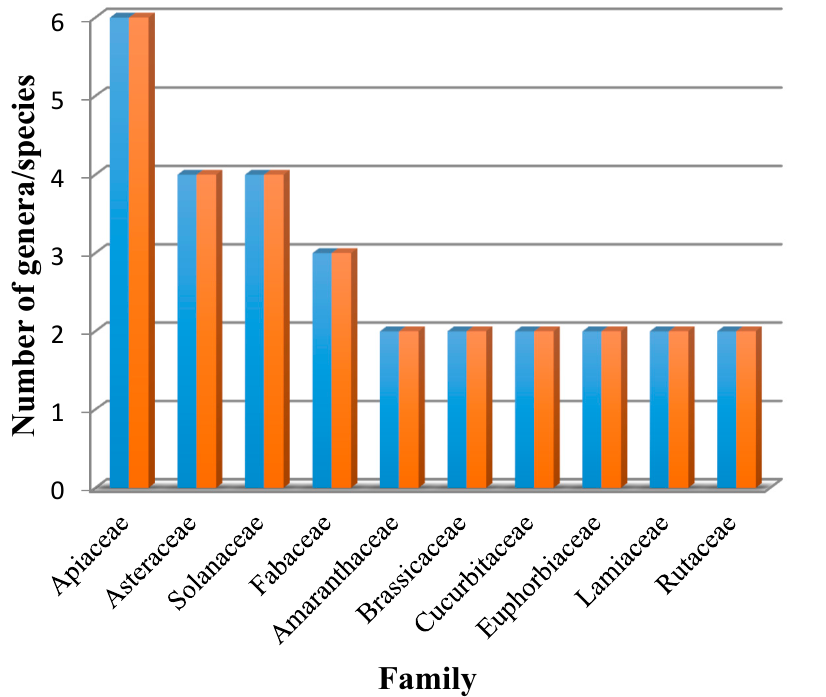
Figure 1. The main families of plants.